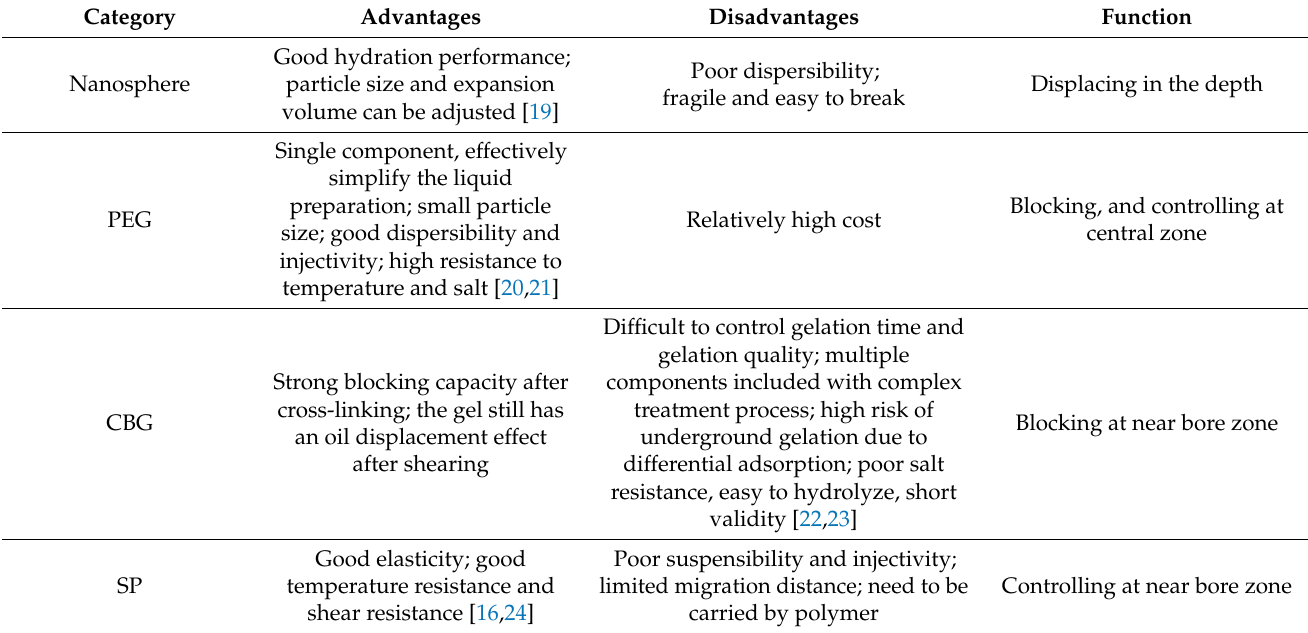
Table 3. Summary of the characteristics of the